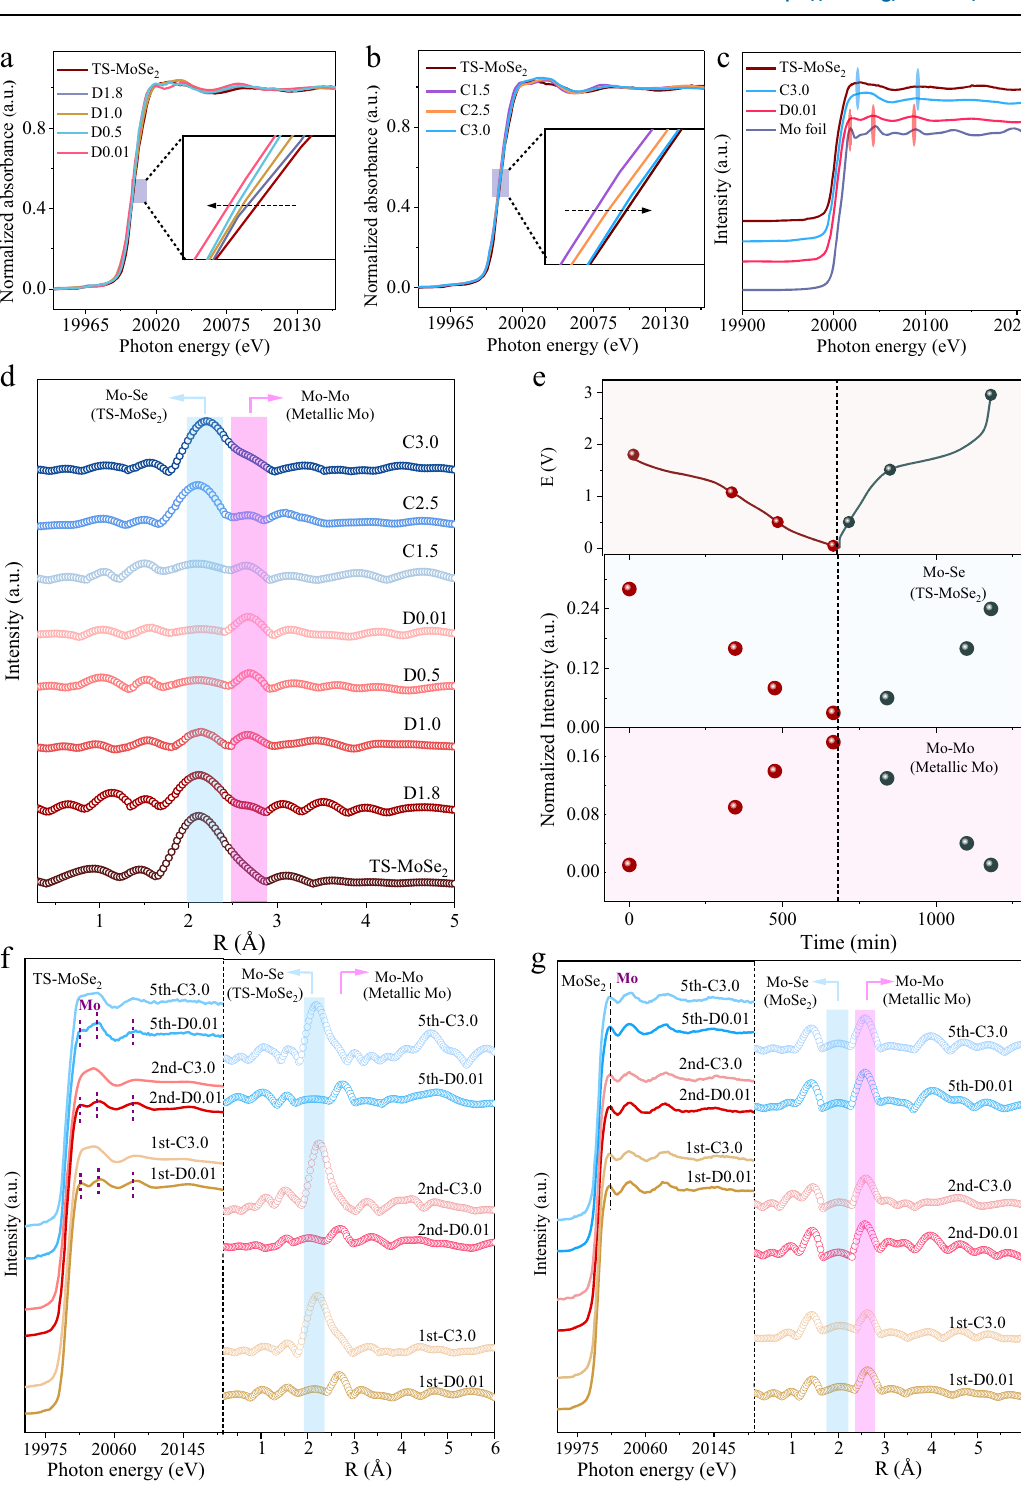
intensity evolution of the Mo-Se peak in TS-MoSe 2 (2.11Å, representing the concentration of TS-MoSe 2 ) and the Mo-Mo peak in metallic Mo (2.69Å, representing the concentration of Mo) during electrochemical cycling. Mo K-edge XANES and EXAFS spectra of TS-MoSe 2 f and MoSe 2 g after the fi rst, second, and fi fth